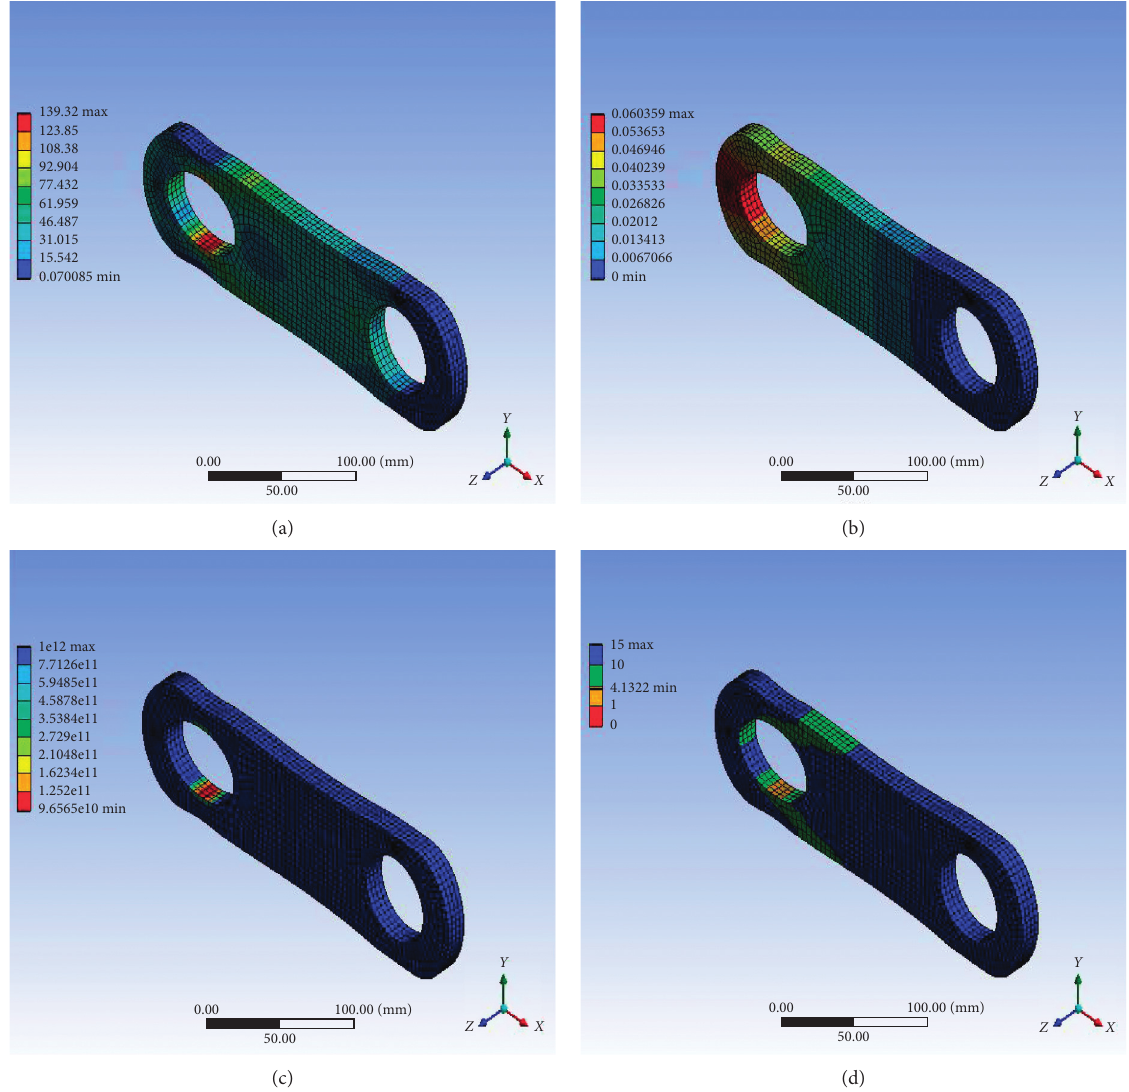
Figure 11: Simulation results for chain link without a modeled crack with neck radius 1245.5mm ( X � 4mm): (a) equivalent stress, (b) deformation, (c) fatigue life, and (d) safety